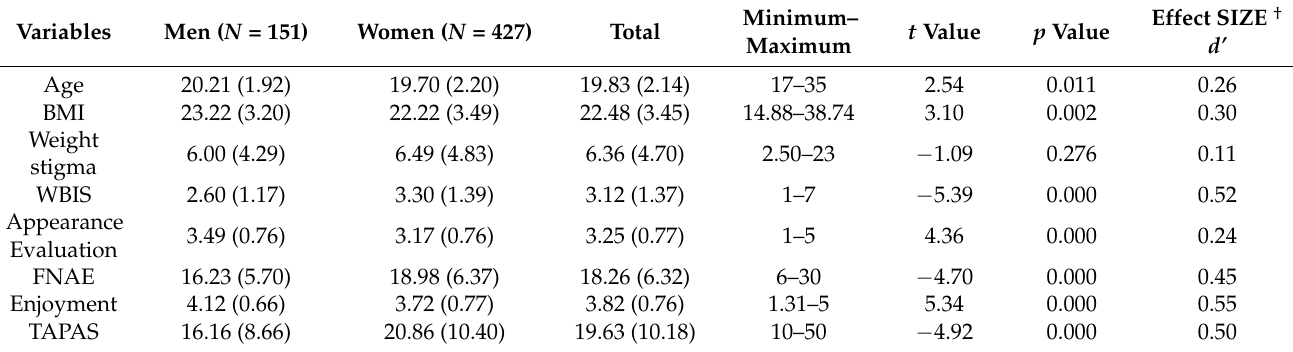
Table 1. Mean ( SD ) participant ratings for men and women on each of the variables along with t -values, significance levels, score ranges, and effect sizes for group